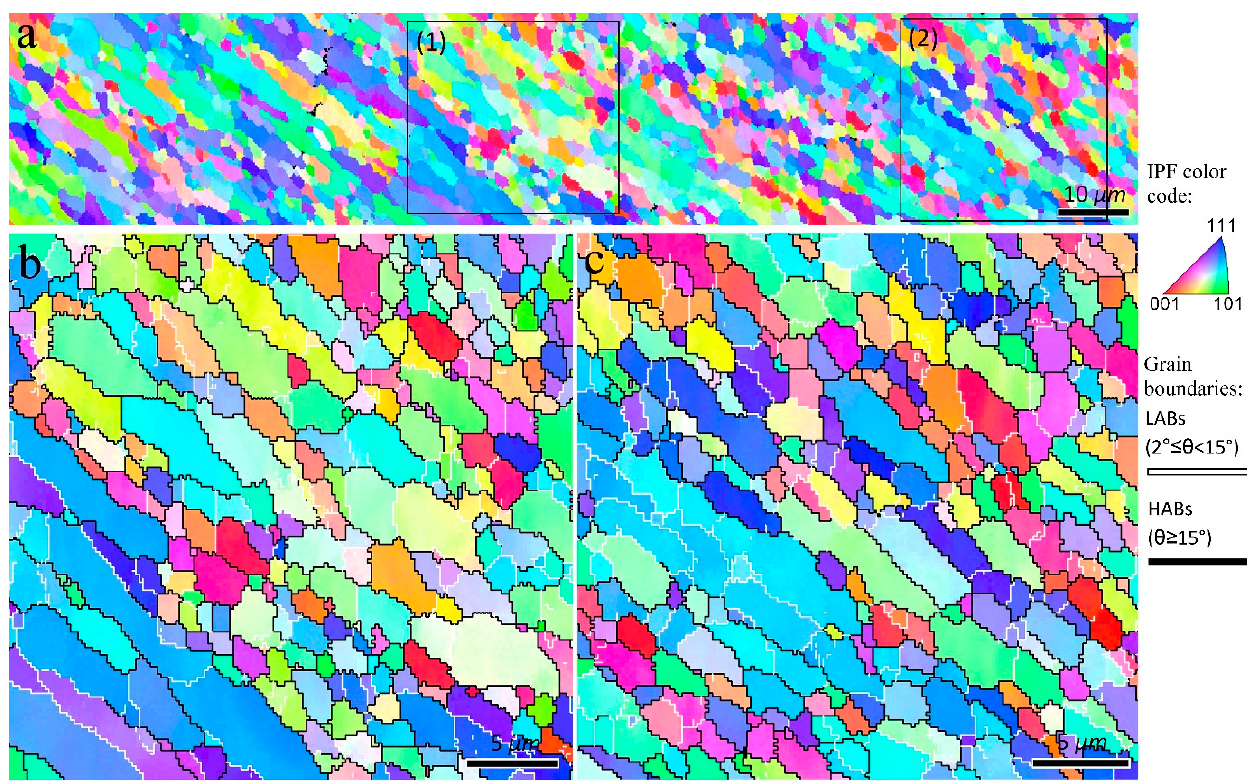
Figure 4. ( a ) Inverse pole figure maps of the TMAZ indicated by rectangle 2 in Figure 2b. Higher magnification of zones 1 and 2 indicated in ( a ) are illustrated in ( b , c ), respectively.